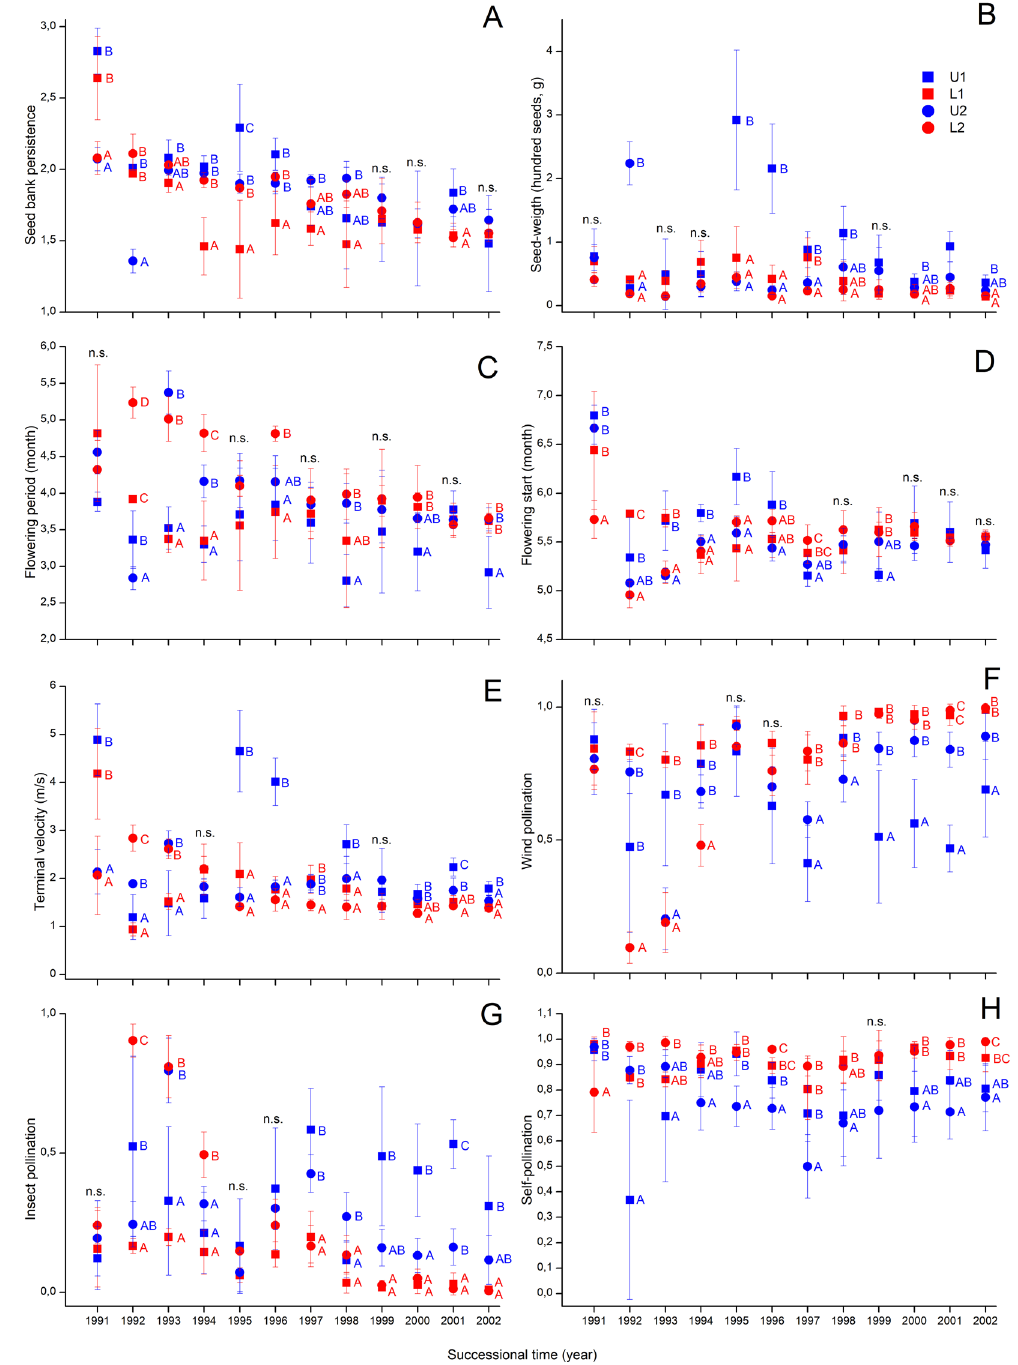
Figure 3. Temporal change of community-weighted means (CWMs) of regenerative traits. Notations: rectangle – sites at the eastern part of the reserve; circle – sites in the western part of the reserve; blue – sites laying near to the dune top; red – sites laying near to the dune slack. Significant differences were indicated by superscript letters (Univariate GLM and Tukey test). Seed bank persistence was based on the ordinal classification of Thompson et al . 33 with three categories; while wind pollination, insect pollination and self-pollination values are the rate of presence/absence data from LEDA 25 and BiolFlor 30